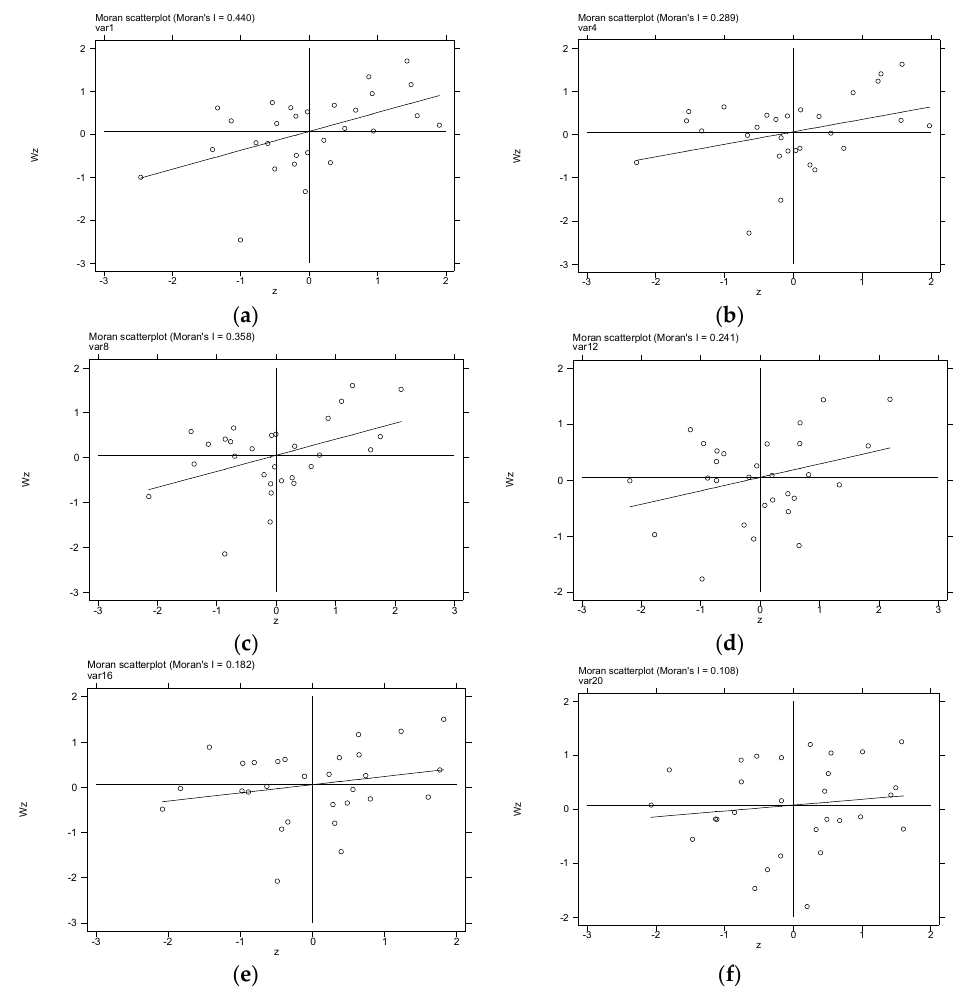
Figure 9. Moran scatter plots of B&R countries’ carbon intensity in different key time points. Notes: Sub-Figure ( a ) is the Moran scatter plot of B&R countries’ carbon intensity in 1995; ( b ) is that in 1998, ( c ) is that in 2002; ( d ) is that in 2006; ( e ) is that in 2010 and ( f ) is that in 2014.